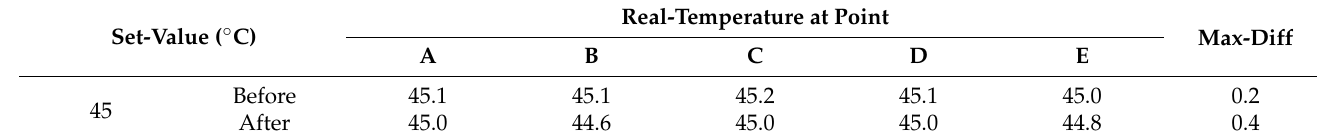
Figure 8. Temperature detection points on material. Table 3. The value of temperature detection points.